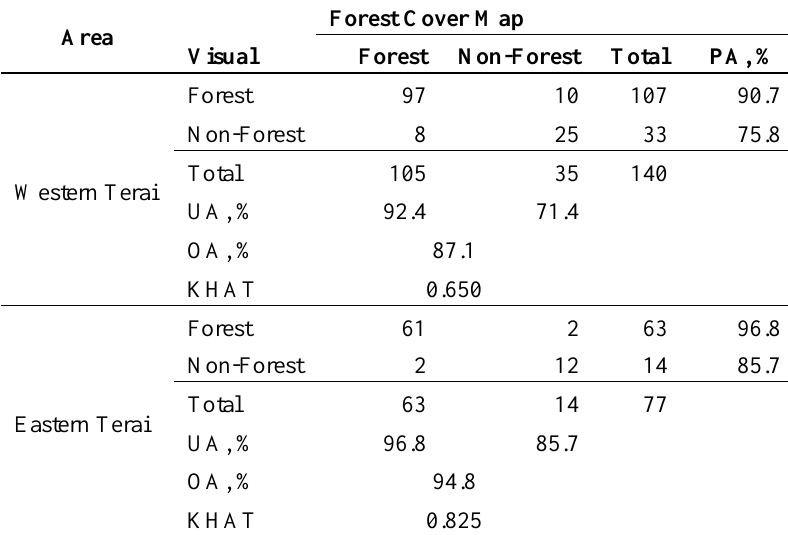
Table 5. Confusion matrices between the forest cover map and the forest cover delineation derived from the visual interpretation (Visual). (UA = User’s accuracy, PA = producer’s accuracy, OA = overall accuracy, KHAT = Kappa